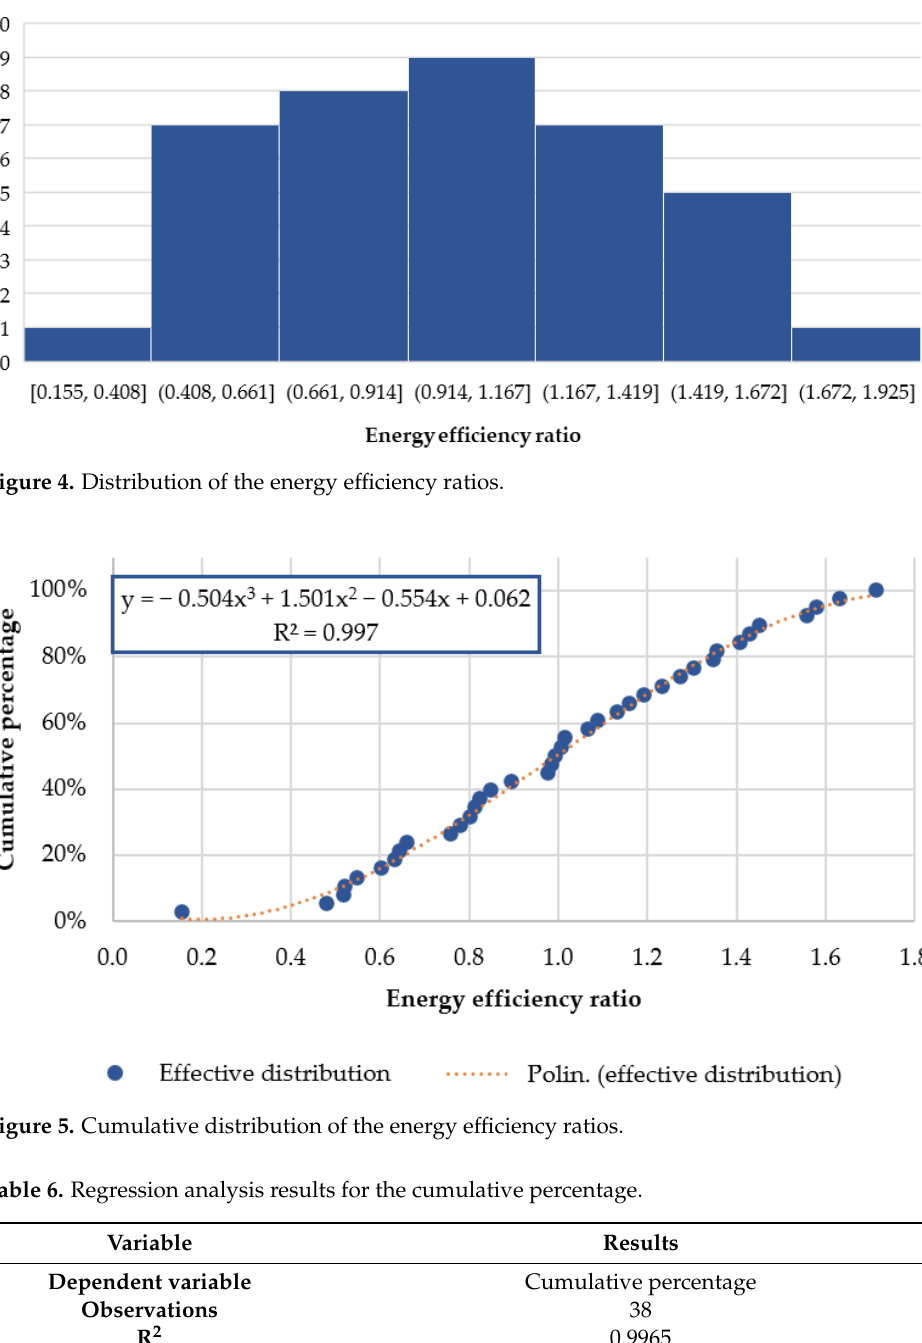
Figure 5. Cumulative distribution of the energy efficiency ratios. Table 6. Regression analysis results for the cumulative percentage.